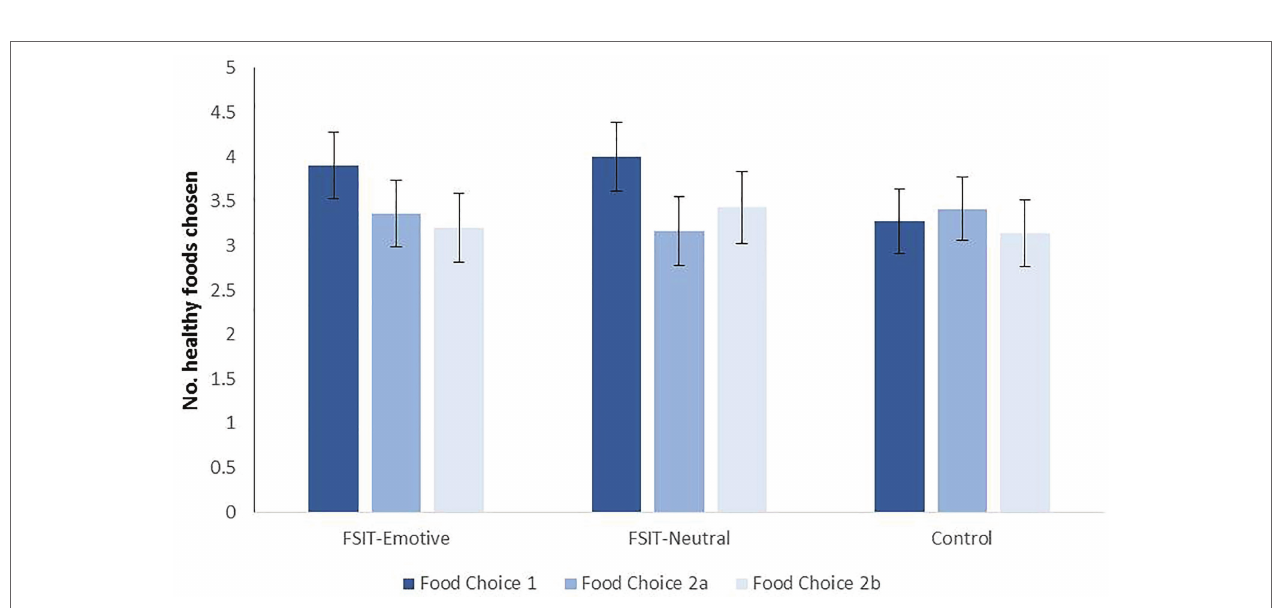
FIGURE 1 | Mean and SE per block for Go trial Reaction Times and proportion of No-Go trial commission errors for each condition across blocks. Lower RTs/error rates indicate better performance.